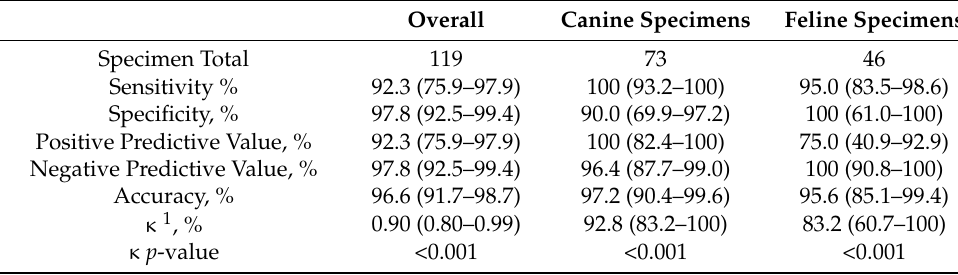
Table 1. Diagnostic characteristics of UTId+ plates compared to conventional urine culture for specimens collected by cystocentesis for dogs and cats presenting to a referral veterinary hospital. Overall Canine Specimens Feline Specimens Specimen Total